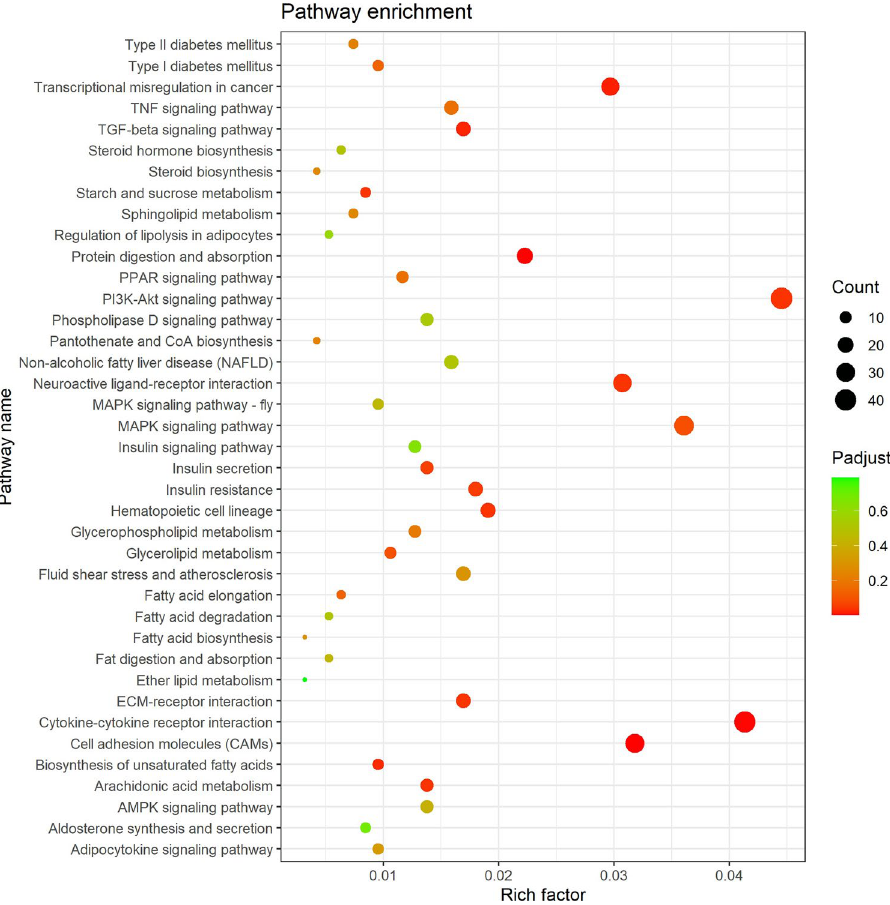
Figure 3. KEGG pathway analysis of differentially expressed genes. Y-axis label represents pathway, and X-axis label represents rich factor (rich factor = amount of differentially expressed genes enriched in the pathway/amount of all genes in background gene set). The size and color of the bubble represent the number of differentially expressed genes enriched in the pathway and significance of enrichment, respectively.